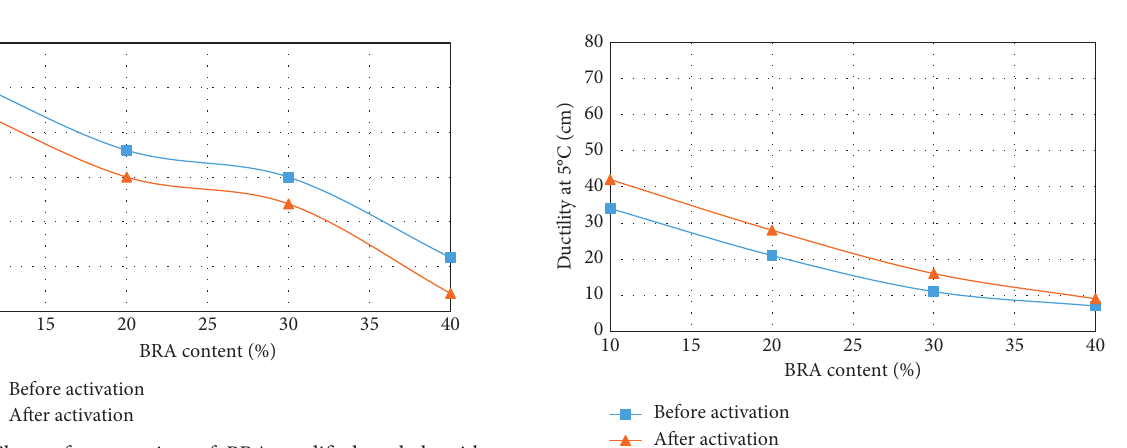
Figure 2: Chart of penetration of BRA-modified asphalt with dosage before and after activation.